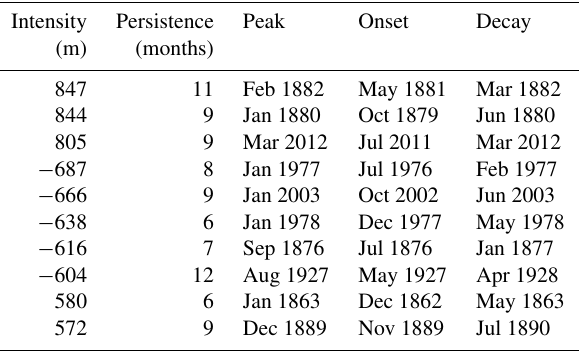
Table 2. A total of 10 dipole events in the 1851–2013 period ranked by the magnitude of their intensities. Results are based on the raw monthly dipole index time